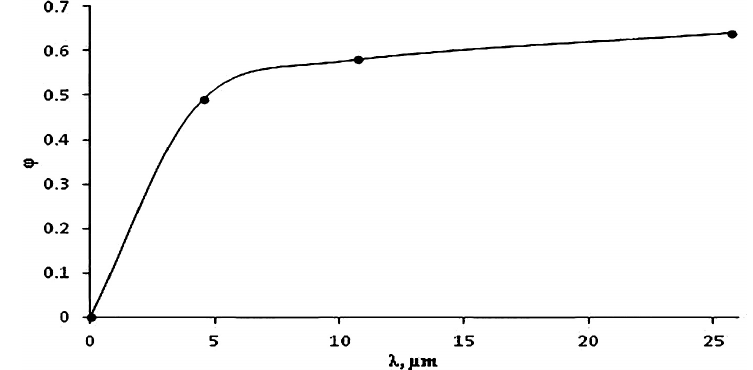
Figure 9. The plot of the variation of the calculated porosity, φ , against the average